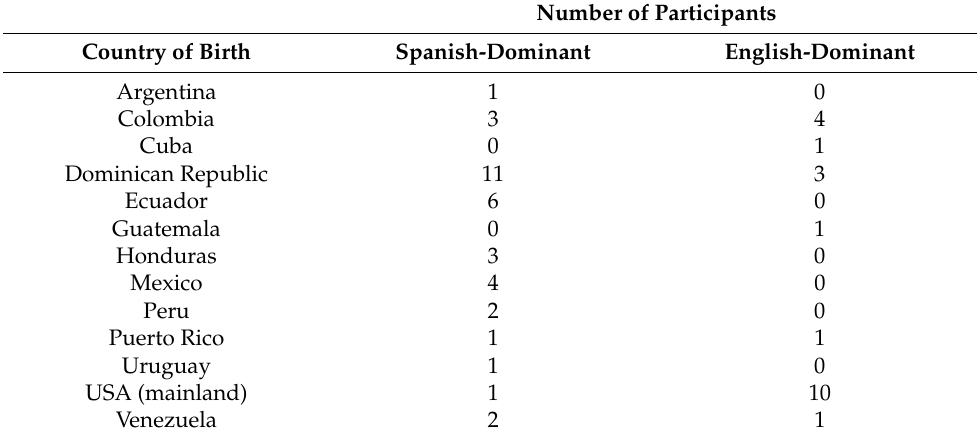
Table 2. Summary of participants’ countries of